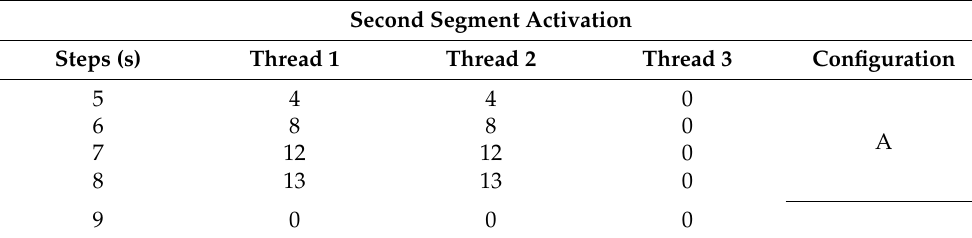
Table 1. Displacement of the threads. Con fi guration A. Source: authors.